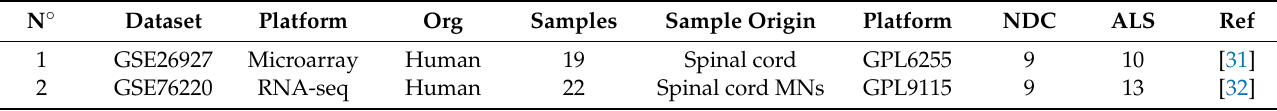
Table 1. Datasets selected.